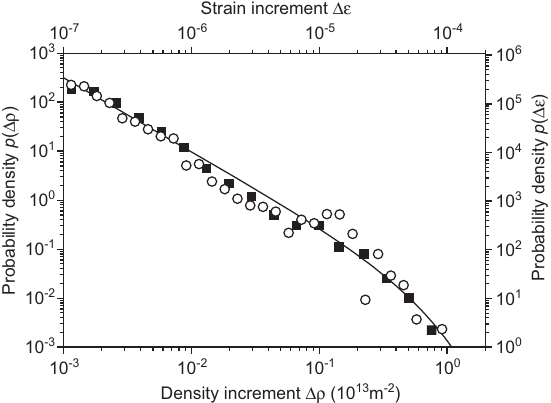
Figure 10 Distributions of strain and dislocation density incre- ments in discrete dislocation dynamics simulations of microbend- ing. The corresponding stress-strain and dislocation density vs. strain curves are shown in Figure 7/Full line, Truncated power law [cf. Eq.